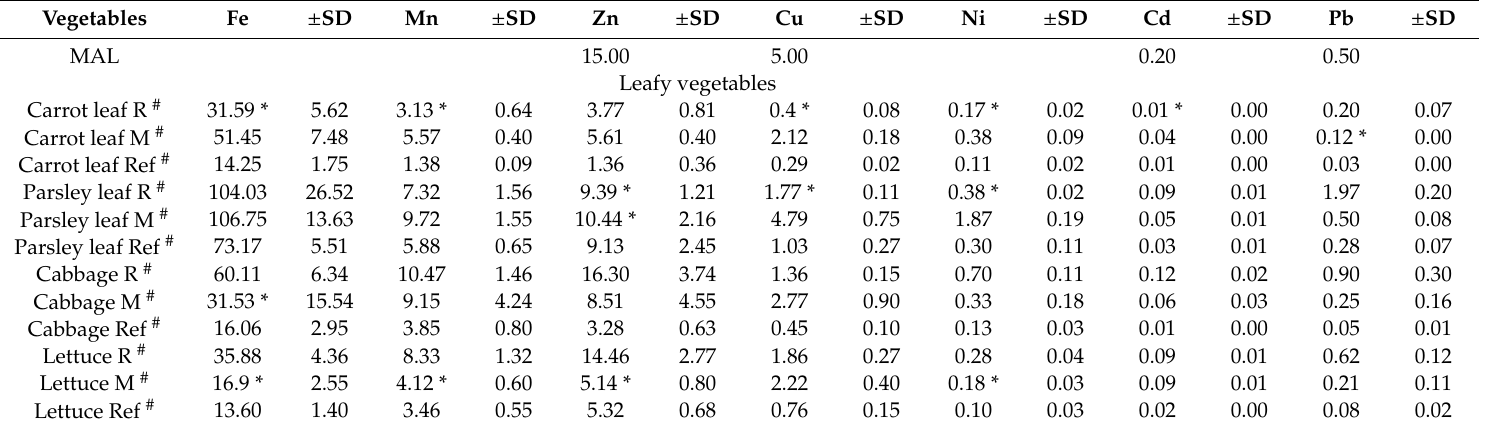
Table 2. Mean (and SD) for metal concentrations in analyzed leafy vegetables (mg / kg FW).